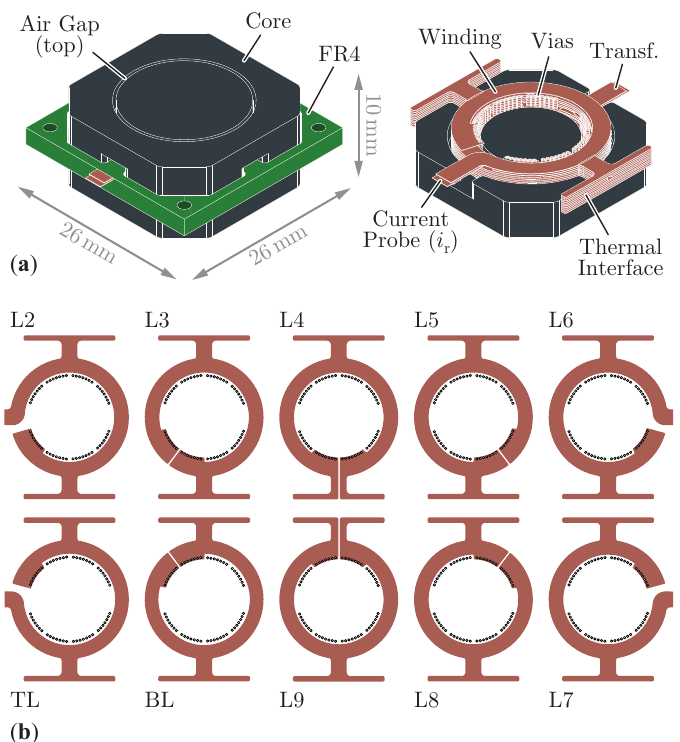
Figure 10. ( a ) The 3-D view of the primary-side inductor ( L r ) with PCB-integrated windings schemat- ically shown with cutaways. Winding heat is transferred by thermal interfaces to adjacent surfaces that can be thermally coupled to heat sinks for cooling. Following [25], air gaps are strategically placed above and underneath the windings to improve current distribution and boost